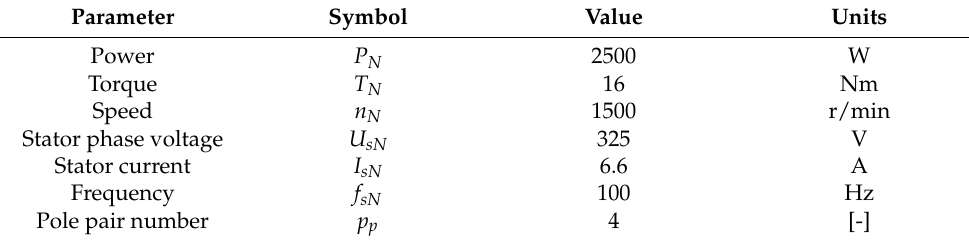
Table 1. Rated parameters of the tested